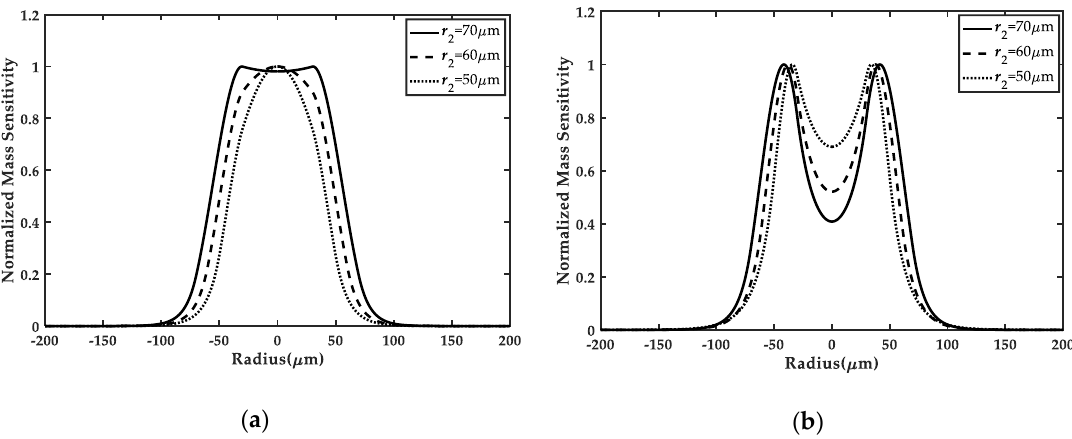
Figure 4. Comparison between the frame-like electrode FBAR ( a ) and the ring electrode FBAR ( b ) [20] for di ff erent r 2 , when r 1 is fixed as 30 µ m and (cid:101) R (cid:48) is equal to 0.04. With the increasing of r 2 , more uniform mass sensitivity distributions are observed for the frame-like electrode. However, it is hard for the ring electrode to achieve uniform